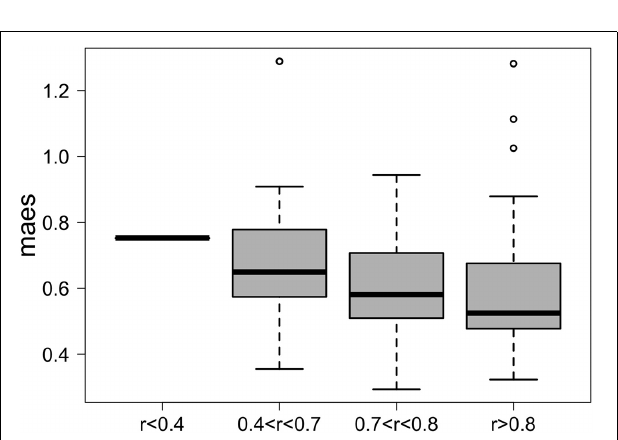
FIGURE 3 | G2S predictions are more accurate when the configurations to be inferred fall within the plane of variation of the training dataset. Box plots of the mean absolute error scaled to one standard deviation (maes) between the real stool microbiome configuration of the samples in the test dataset and the median configuration of the training dataset. Samples were divided into four groups based on the quality of the G2S predictions (i.e., the Spearman correlation coefficients between the real values and the inferred configurations).